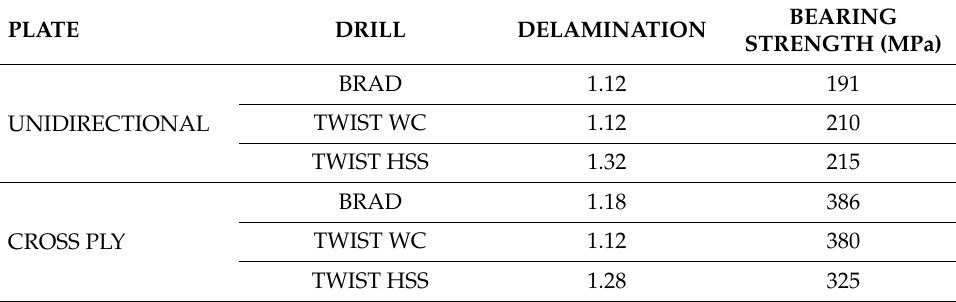
Table 4. Delamination factor (Equation (2)) and bearing strength of drilled plates.